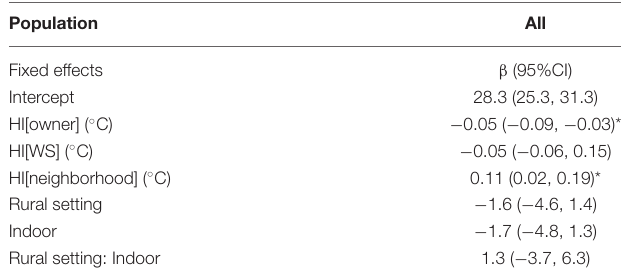
TABLE 4 | Linear mixed effect model results with dog’s individually experienced HI in 24h as the